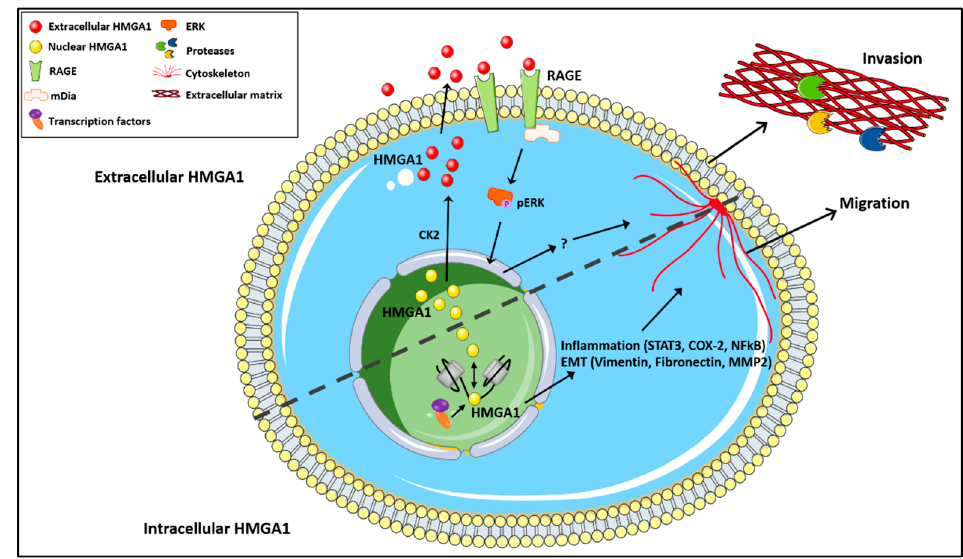
Figure 1. HMGA1 was recently discovered in different cellular compartments during tumorigenesis. The scheme illustrates known molecular mechanisms that mediate HMGA1 function in cancer.